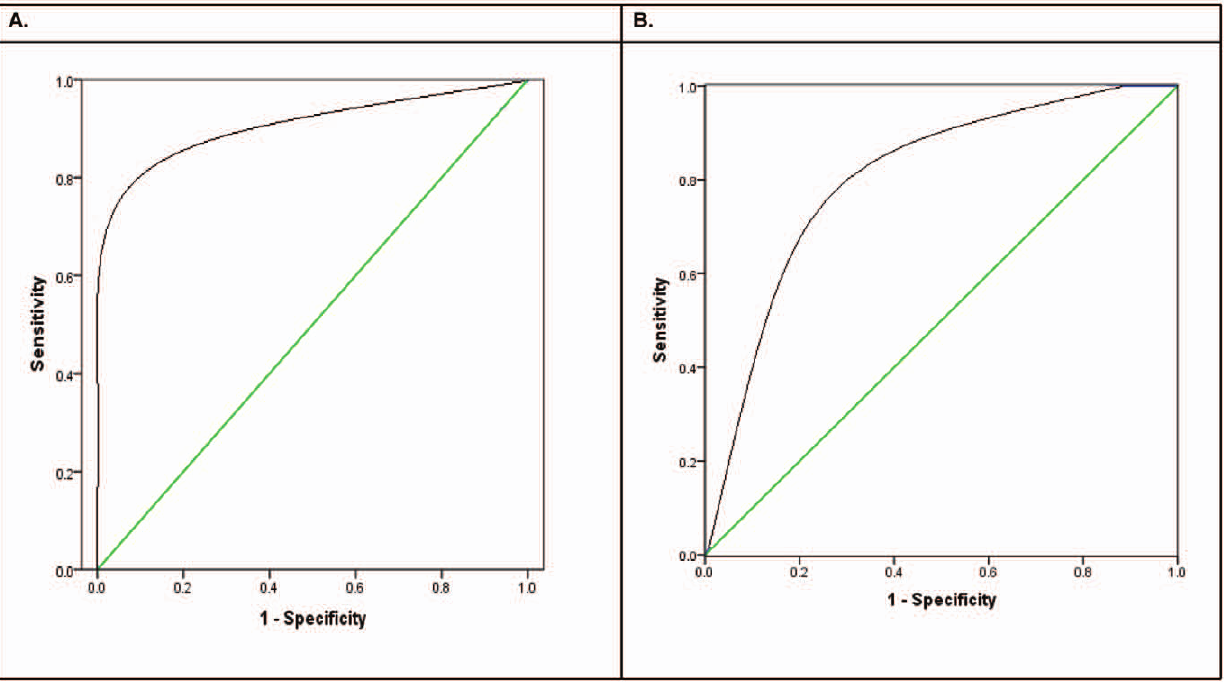
Figure 1. Receiver operating characteristic curves of correct HLA allele predictions at different prediction probability cut-off points. (A) HLA-DRB1, AUC=0.86 (95% CI=0.78–0.99), P=0.001. (B) HLA-DQB1, AUC=0.73 (95% CI=0.59–0.87),